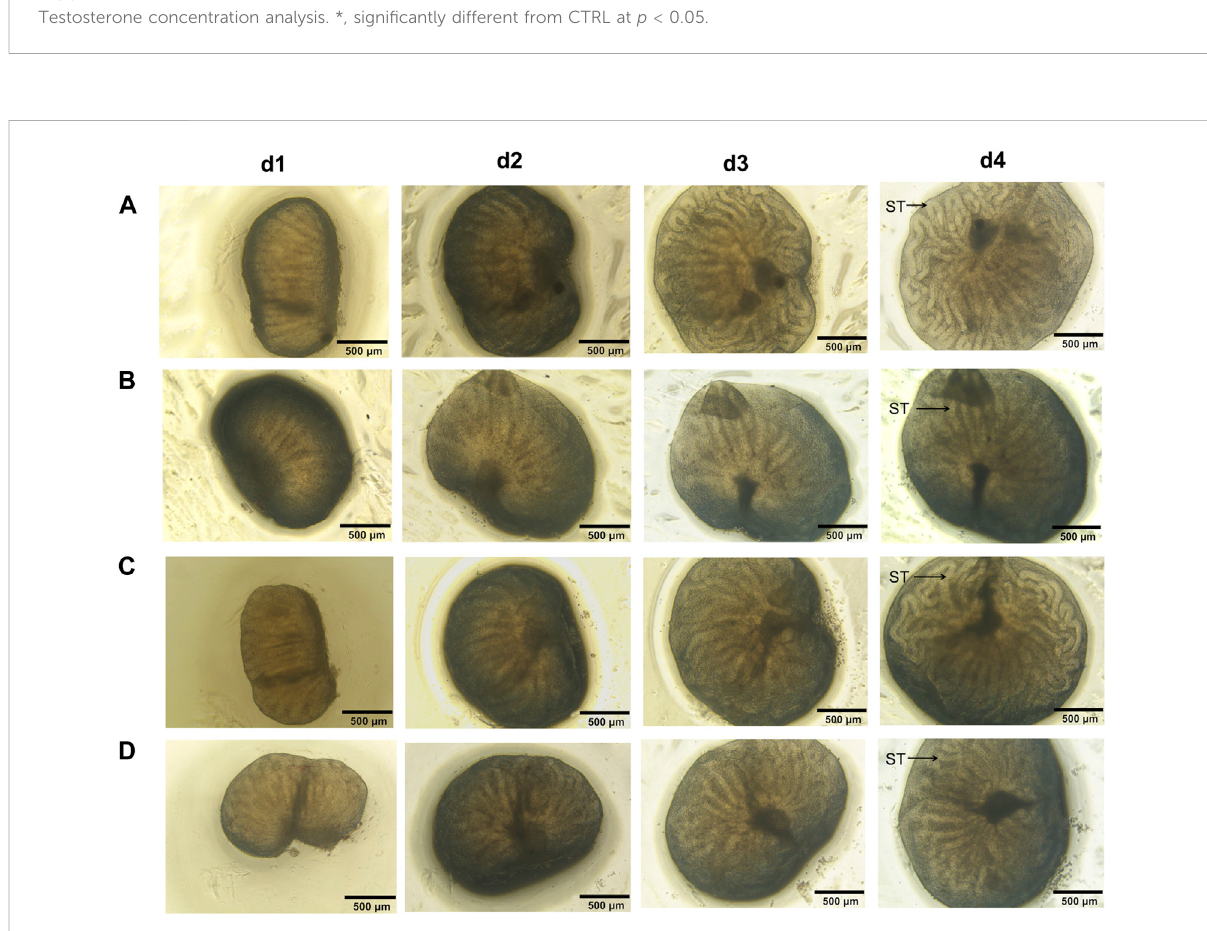
FIGURE 8 Testicular morphology of the cultured fetal testis. The volume of fetal testis increased, seminiferous tubules on d4 in all groups were more coiled than before and no obvious alteration of testicular morphology was observed in all treated groups. ST, seminiferous tubules. ×40 magni fi cation. Scale bars indicate 500 µm. (A) control; (B) group M; (C) group G; (D) group M +